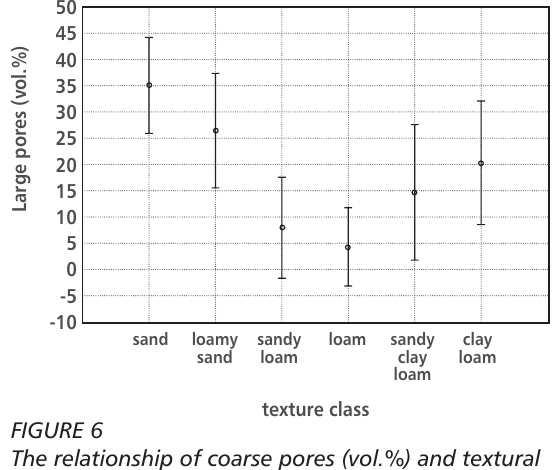
FIGURE 6 The relationship of coarse pores (vol.%) and textural classes in all samples